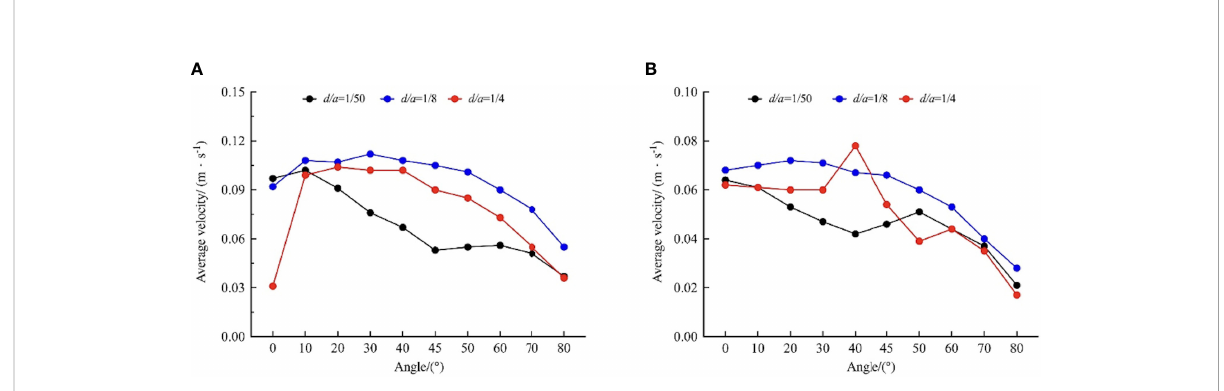
FIGURE 10 Distribution of the average velocity under different conditions: (A) Single-inlet mode; (B) Dual-inlet mode.